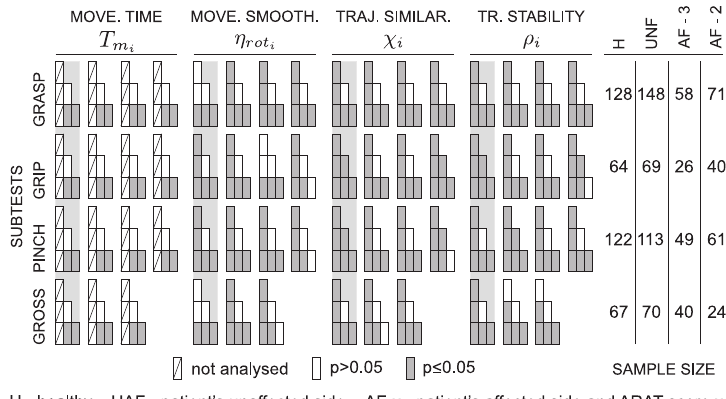
Figure 7. Statistical significance for the subtests. Four subtests, grasp, grip, pinch and gross, quantified with four parameters: movement time, movement smoothness, hand trajectory similarity, and trunk stability. Presentation is organized as explained in Figure 6. The columns on the right side represent the number of trajectories included in statistical analysis for each